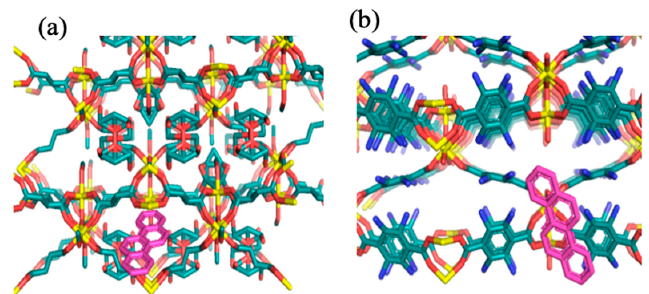
Figure 7. The molecular docking structure of ( a ) MIL-88(Fe) and ( b ) NH 2 -MIL-88(Fe) with the CRY molecule, for the binding interactions [229]. Copyright: Elsevier (2020). Metal (Fe), carbon (C), oxygen (O), and nitrogen (N) are colored as yellow, green, red, and blue, respectively. The CRY is indicated in purple.